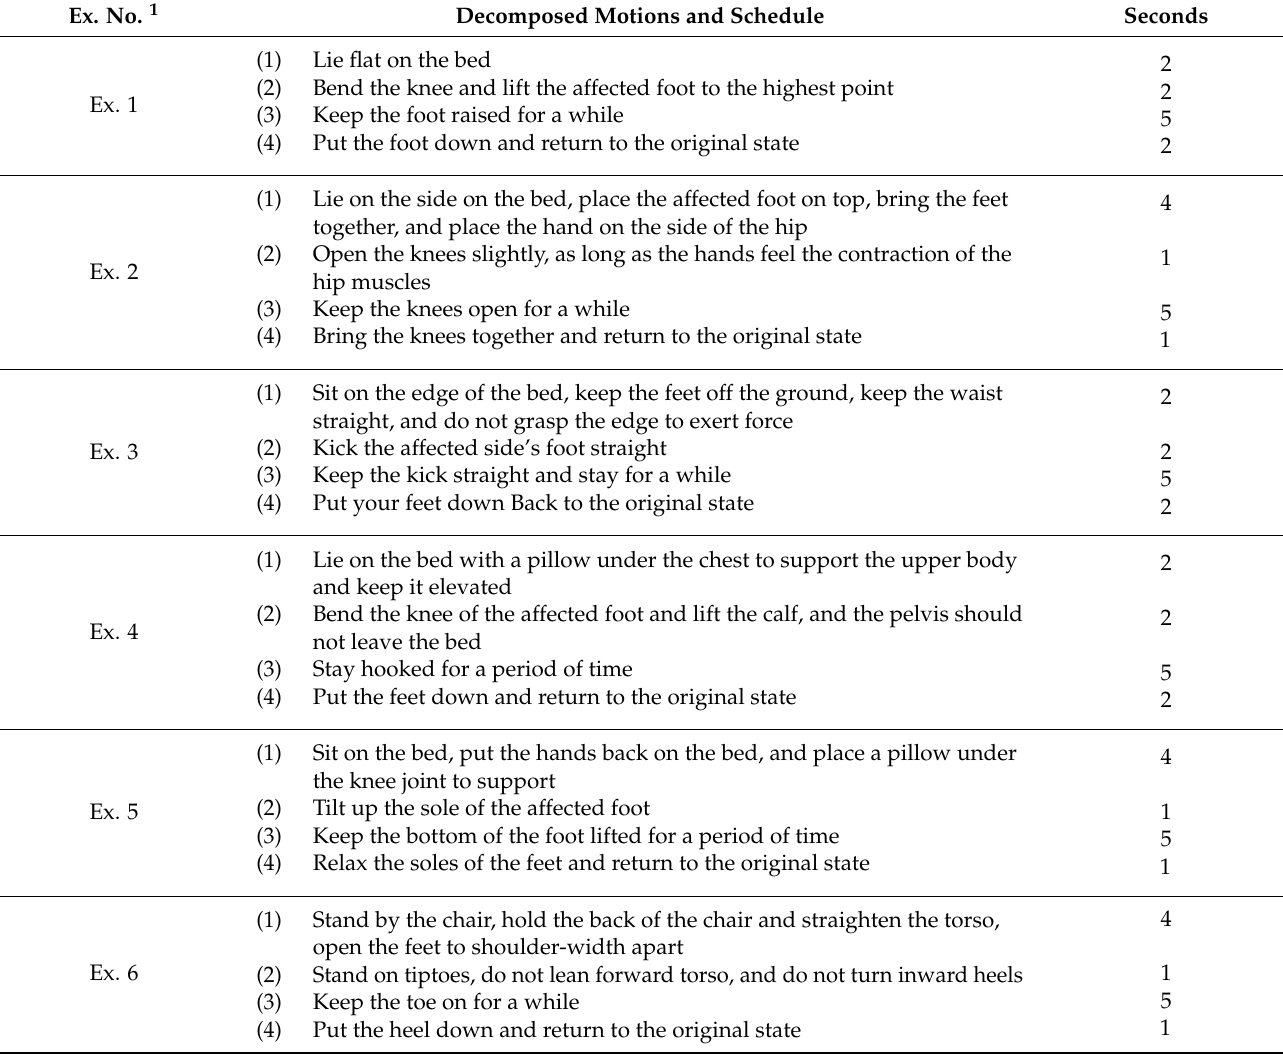
Table 2. The motion guide and schedule designed for the lower-limb exercises. Ex. No.